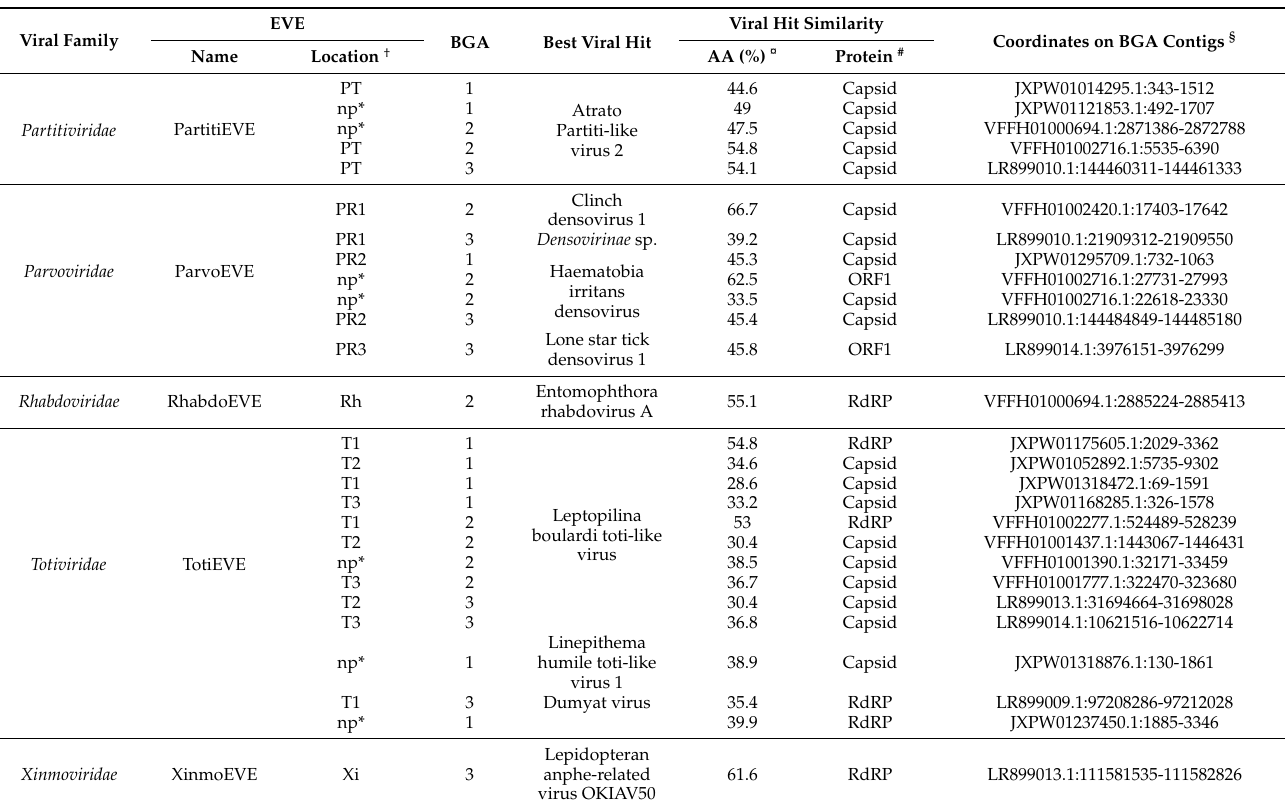
Figure 1. Positions of EVE candidates in the genome of BSF, assembled at the chromosome level (BGA3). Letters represent specific sites of related EVE sequences. The letters represent sites where certain EVE sequences obtained from BGA1, 2 & 3 that were related to Partitiviridae (PT), Parvoviridae (PR1, PR2, PR3), Rhabdoviridae (Rh), Totiviridae (T1, T2, T3) and Xinmoviridae (Xi) could be mapped. The asterisks indicate which EVE site was found on at least two of the three BGAs. Sequences can be found in Table S3. Table 1. Summary of EVE sequences found in three BSF